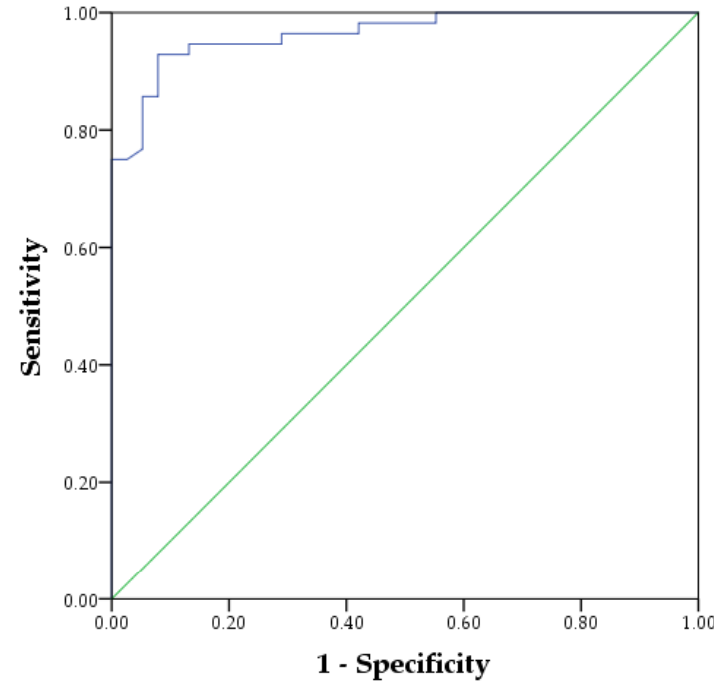
Figure 1. The ROC curve of the classification model for CHD.